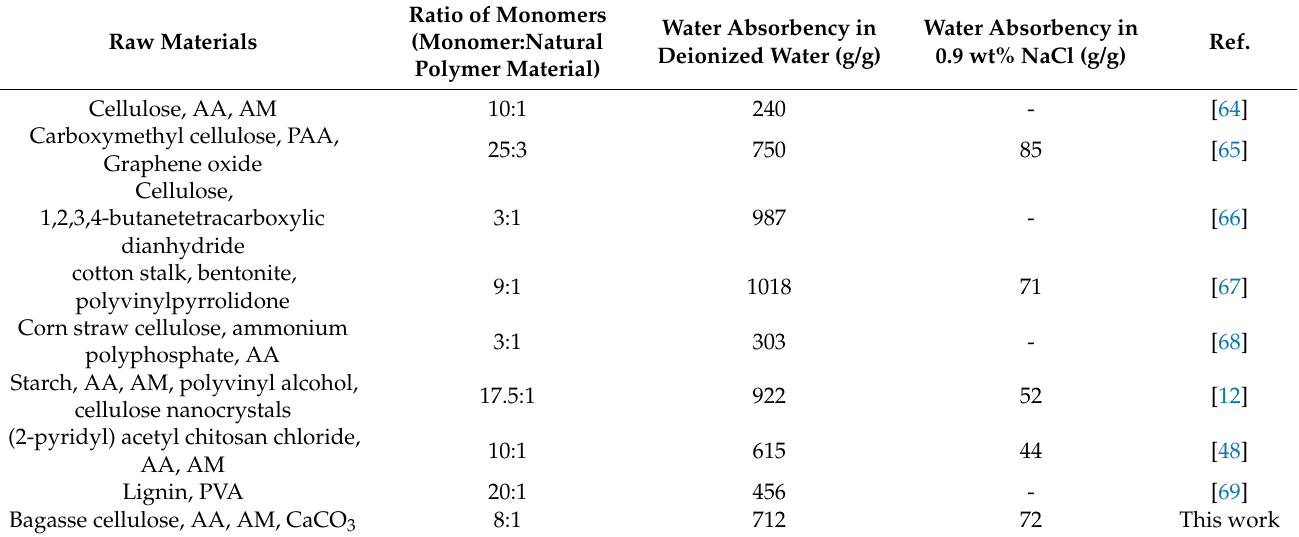
Table 1. Comparison of water absorbency of CAAMC with that of other